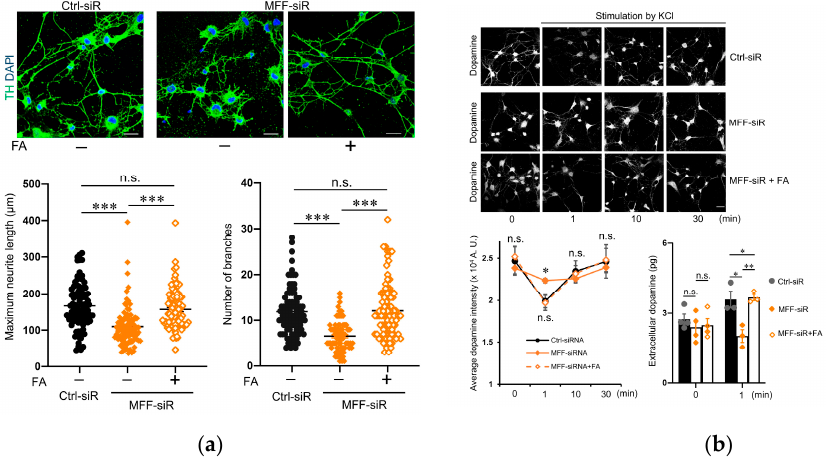
Figure 7. FA supplementation improved developmental defects in DNs with MFF insufficiency. ( a ) DNs were stained with anti-TH antibodies and DAPI. Scale bars = 25 μ m. Maximum neurite length and number of branches per cell are shown. The mean ± SEM was taken from three independent